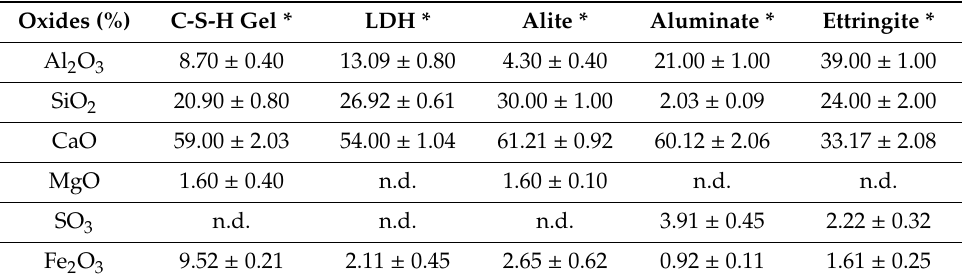
Table 6. Chemical analysis by EDX (* indicates the analysis point from Figure 8; n.d.—not detected).